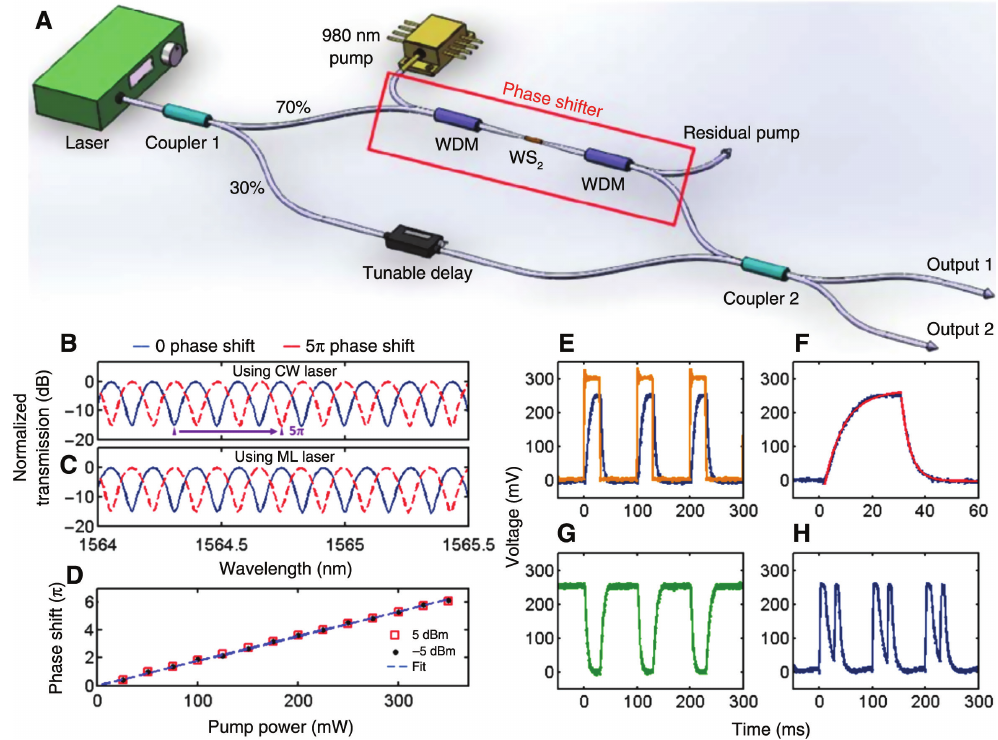
-deposited microfiber. Figure 18: All-fiber phase shifter and optical switch based on a WS 2 (A) Experimental setup. (B–D) Transmission spectra of the MZI with 0 (blue) and 5 π phase shift (red) using (B) a continuous wave laser source and (C) a mode-locked laser source. (D) Phase shift with respect to the injected pump power with two input power levels. (E) Pulsed pump light (yellow) and switch output at “output 1” port (blue). (F) A zoomed view of a single off-on-off transition of the switch (blue) and exponential fit (red), (G) complementary output at “output 2” port. (H) Output breaking when the MZI is over-driven. Reproduced with permission [279]. Copyright 2017, The Optical